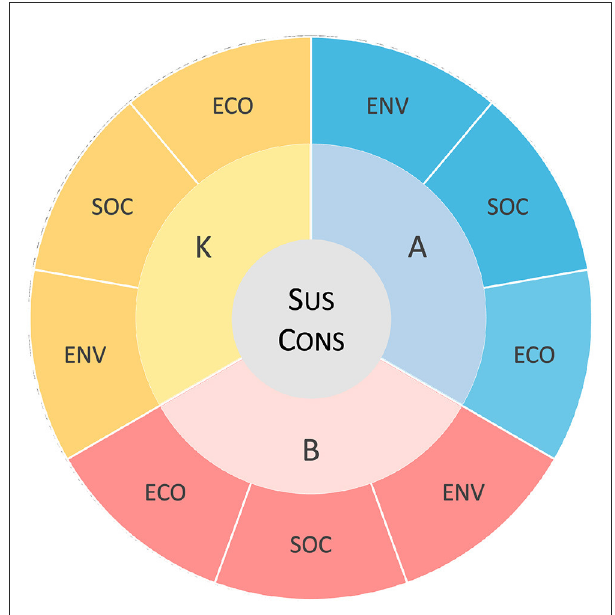
FIGURE1 Conceptual representation of the sustainability consciousness questionnaire. K, knowingness; A, attitudes; B, behavior; ECO, economic; SOC, social; ENV, environmental; Sus Cons, sustainability